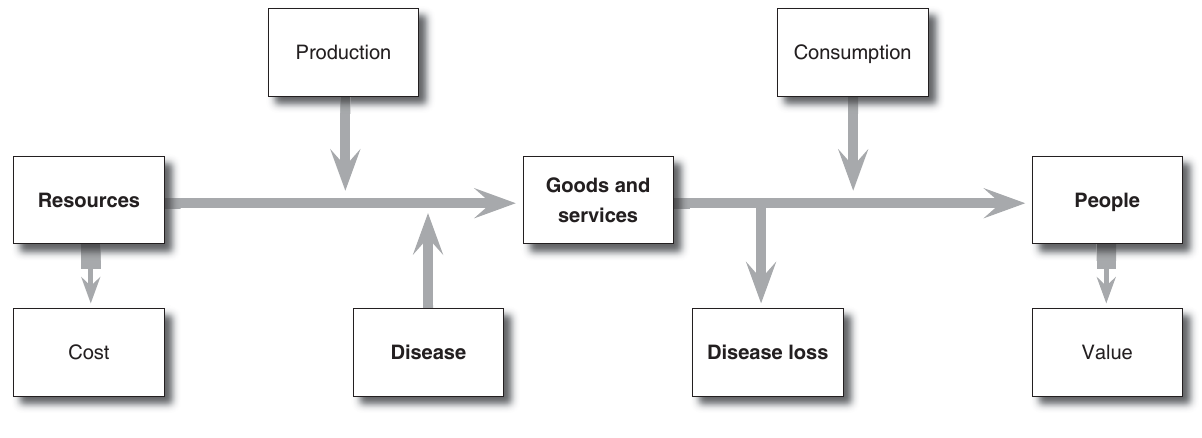
PeopleResources